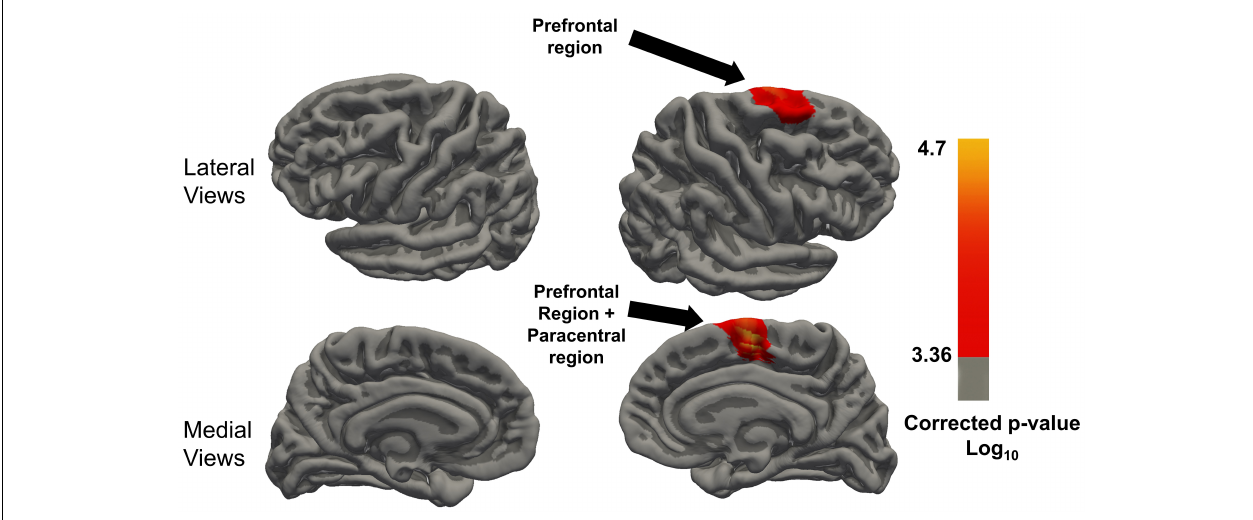
FIGURE 4 | Regions with significant Time x LMX1A (AA vs. GA and GG) interaction on cortical thickness after FDR correction of the P -value, minimal significant FDR corrected P threshold is 10 ( - 2 . 58 ) = 0.00043. Resampled surface maps, were smoothed with kernel factor of 30 mm (fwhm). Brain regions showing significant group differences (after FDR correction) in the right hemisphere include the superior frontal region, and paracentral region. In the left hemisphere, there was no significant group difference in any region. TABLE 2 | Cortical thickness (Mean( ± SE)) of regions of interest that show training LMX1A effects, with cluster size of significant vertices. Timepoint 1 Timepoint 2 Timepoint